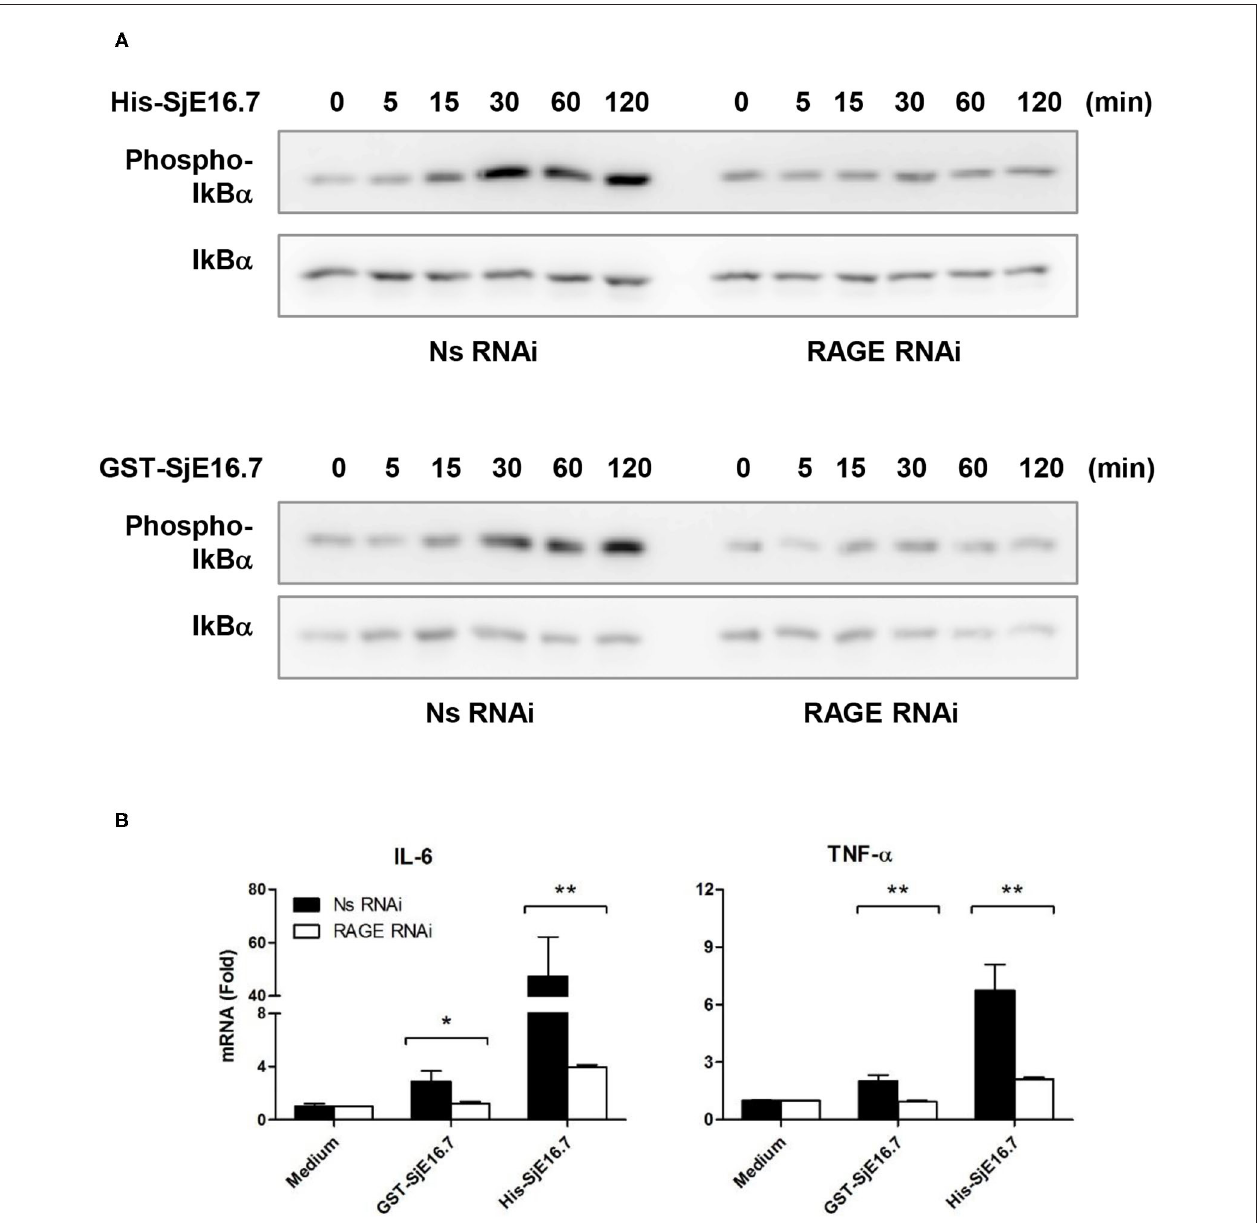
FIGURE 4 | RAGE is essential for SjE16.7-induced NF- κ B signaling activation and proinflammatory cytokine production. (A) The expression of RAGE in RAW 264.7 cells was knocked down by lentivirus-mediated RNA interference (RNAi). The cells were then stimulated with 1 µ M eukaryotic recombinant protein His-SjE16.7 or prokaryotic recombinant protein GST-SjE16.7 for the indicated times. The levels of phospho-I κ B α and total I κ B α , phospo-p65 and total p65 were determined by Western blot. Results are representative of two experiments. (B) RAGE knockdown RAW 264.7 cells or control cells were stimulated with 1 µ M recombinant His-SjE16.7 or GST-SjE16.7 for 2h. IL-6 and TNF- α mRNA levels were determined by real-time PCR. Statistical analysis was performed on pooled data from three independent experiments. * p < 0.05, ** p <